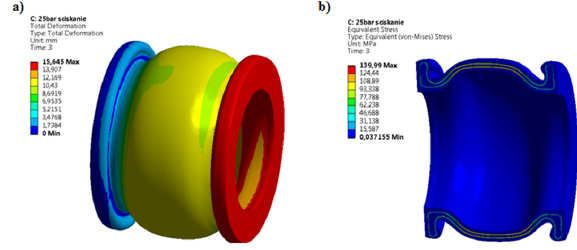
Figure 14: The deflection and von Misses stress distribution of the elastic diaphragm made of EPDM rubber. Load case: compressive deflection at 15 deg. and internal pressure 20 bar, a) generalized deflection, b) von Mises stress distribution